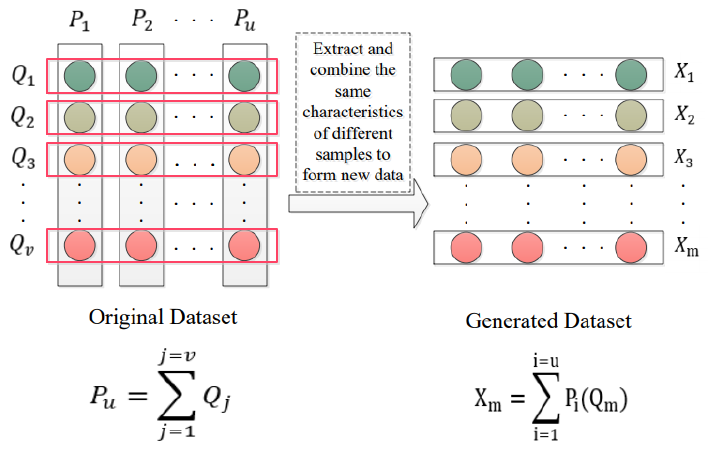
Figure 4. The process of data